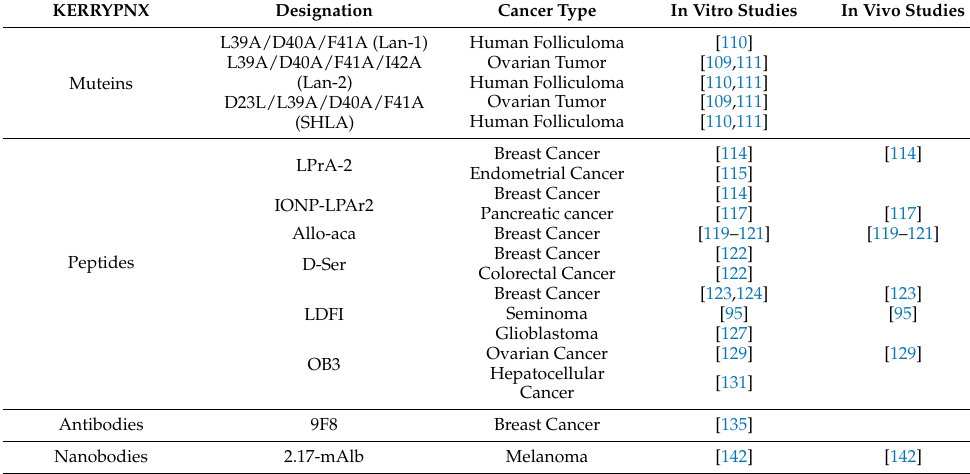
Table 1. The main leptin modulators with anticancer